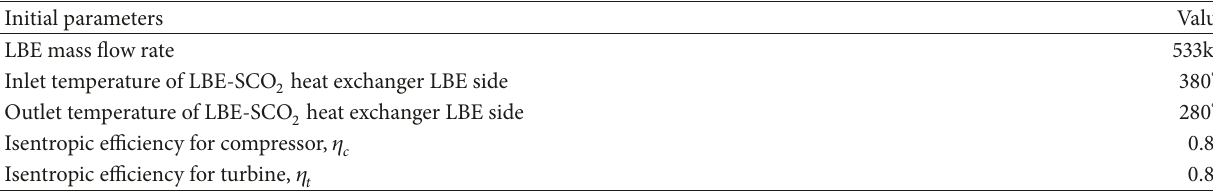
Table 2: Initial parameters for simulation and analysis of